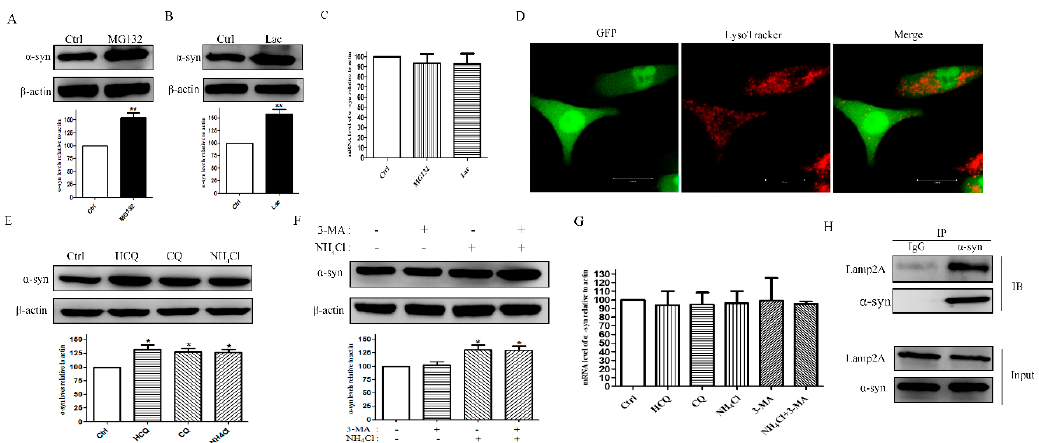
Figure 3. WT α -syn was degraded by the proteasome and the CMA pathway. PC12 cells stably overexpressing WT α -syn were treated with 10 µ M MG132 ( A ) or 10 µ M Lac ( B ) for 24 h. Cells were lysed and subjected to SDS-PAGE by using an anti- α -syn antibody. ( C ) Cells were treated with 10 µ M MG132 or 10 µ M Lac for 24 h and mRNA levels of WT α -syn were detected by using the RT-PCR. ( D ) Cells were labeled with a Lyso-Tracker for 20 min and was visualized by using a confocal microscopy. Representative images were shown. Scale bar: 10 mm. ( E ) Cells were treated with 100 µ M CQ, 30 mg/mL HCQ, and 20 mM NH 4 Cl for 24 h. Cells were harvested and subjected to SDS-PAGE using an anti- α -syn antibody. ( F ) Cells were treated with 10 mM 3-MA and 20 mM NH 4 Cl for 24 h. α -Syn levels were determined by using Western blotting analysis. ( G ) Cells were treated with 100 µ M CQ, 30 µ g/mL HCQ, 20 mM NH 4 Cl, 10 mM 3-MA, and a combination of NH 4 Cl with 3-MA for 24 h. RT-PCR was conducted to assess the mRNA levels of WT α -syn. ( H ) Lysates from PC12 cells were immuno-